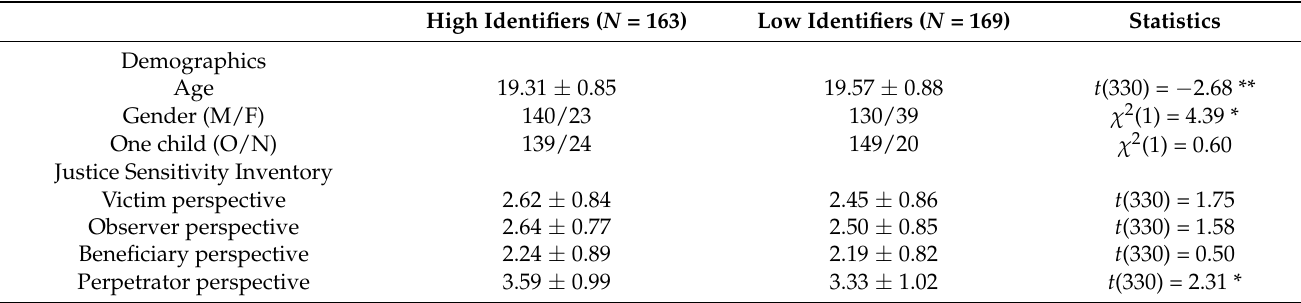
Table 1. Sample characteristics in Study